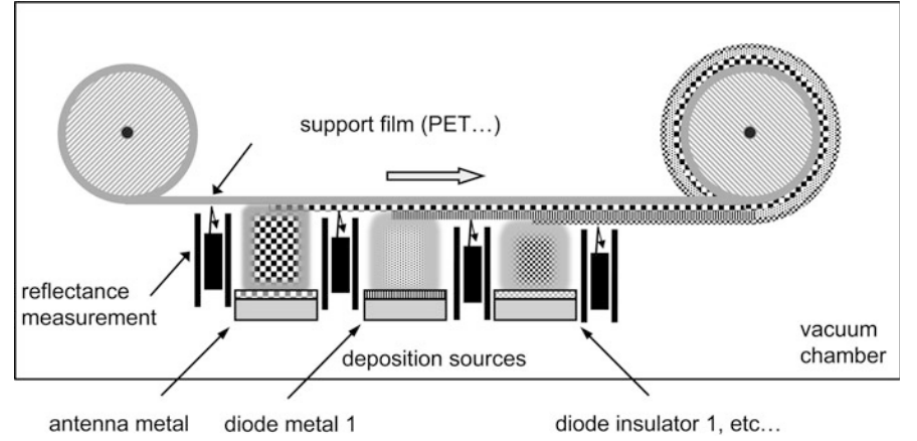
Figure 14. The suggested roll to roll chamber to produce rectennas (Reproduced with permission from [107], Springer,